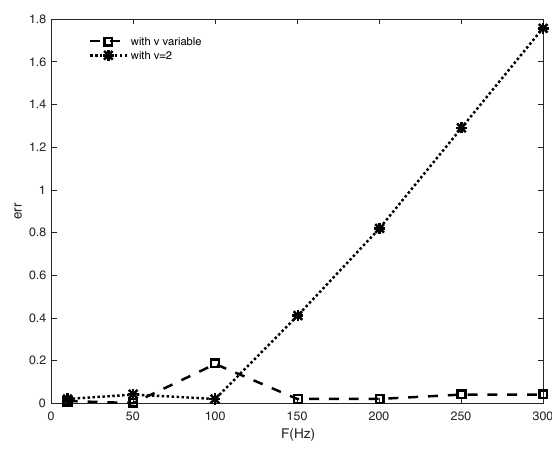
FIGURE 8. Modelled and measured hysteresis loops at 250 Hz with n variable